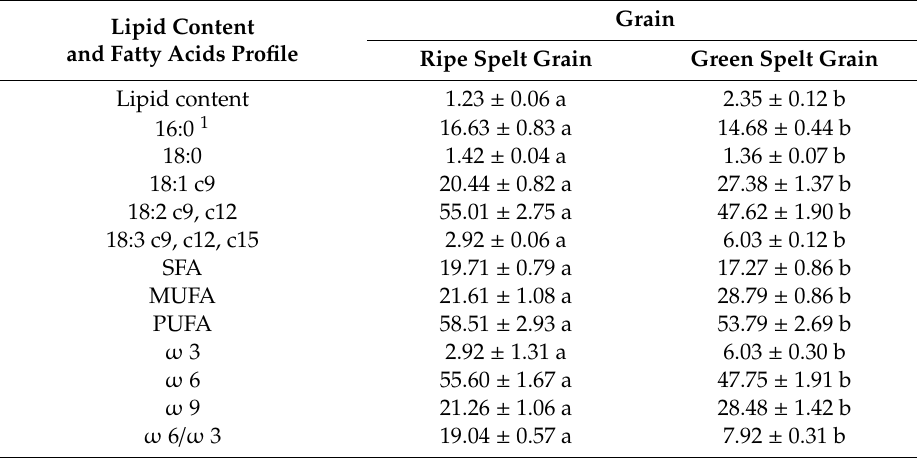
Table 7. Lipid content [%] and the fatty acids profile [%] in spelt